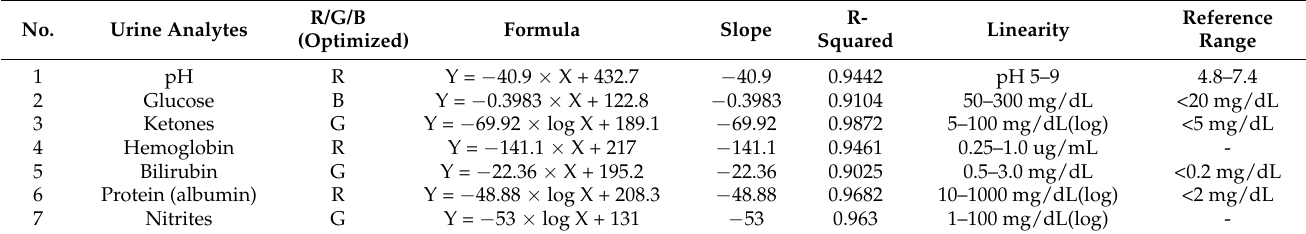
Table 1. RGB characteristic values of analysis factors by urine dipstick concentration.